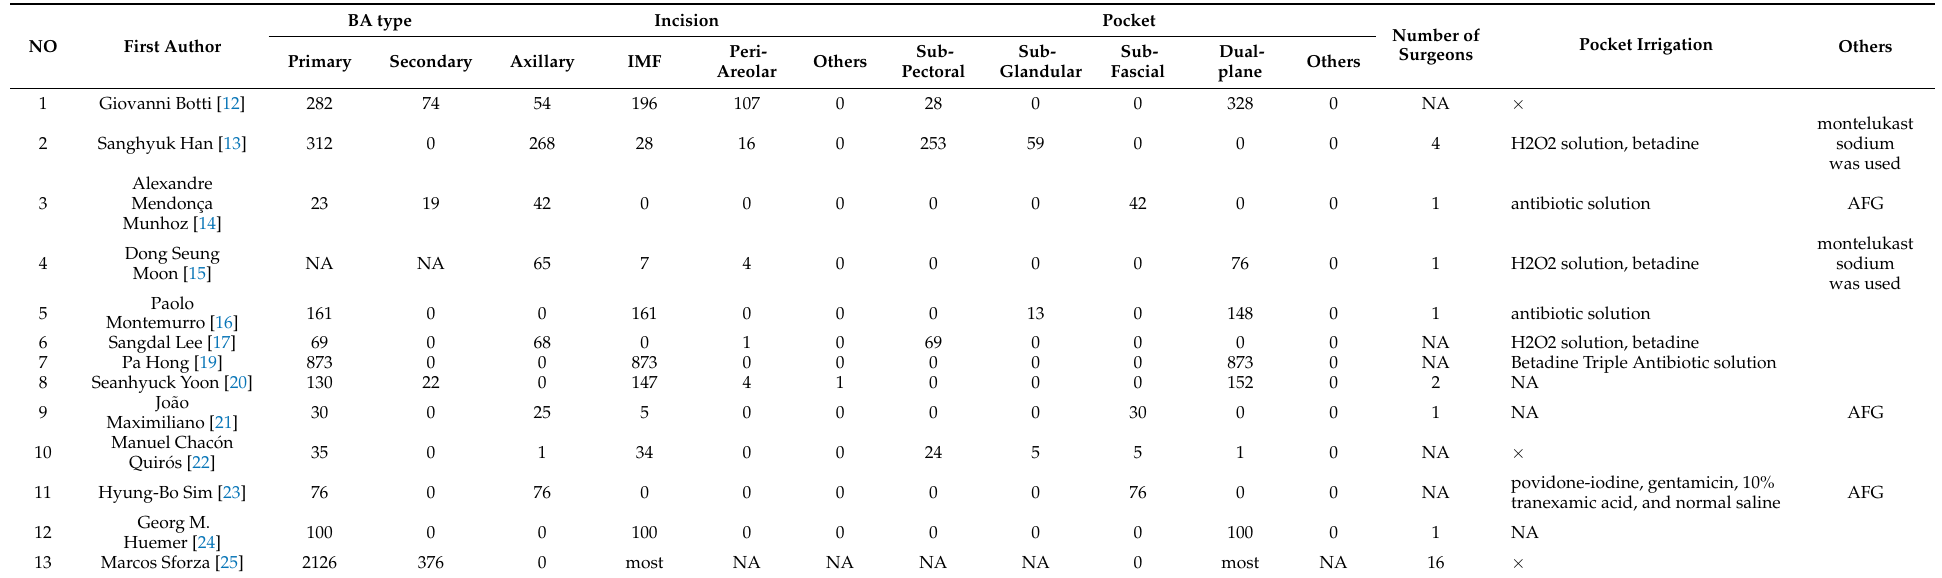
Table 3. The surgical techniques of included